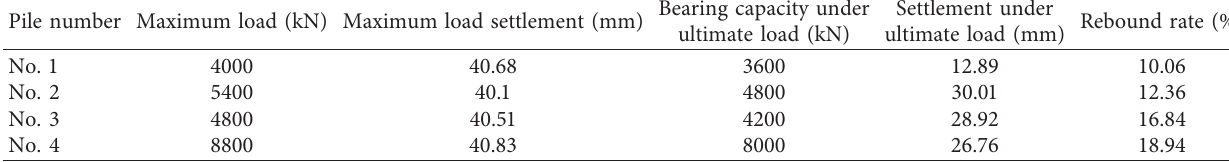
Table 5: Results of static load test.